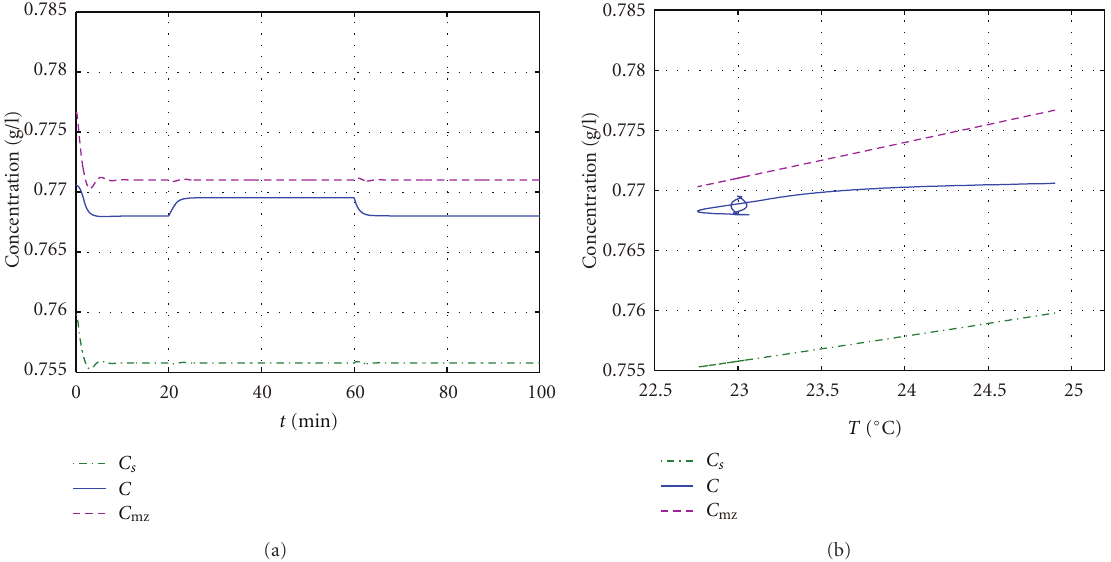
Figure 3: Concentration profiles inside the crystallizer when step changes are imposed to the output variable μ 3 .